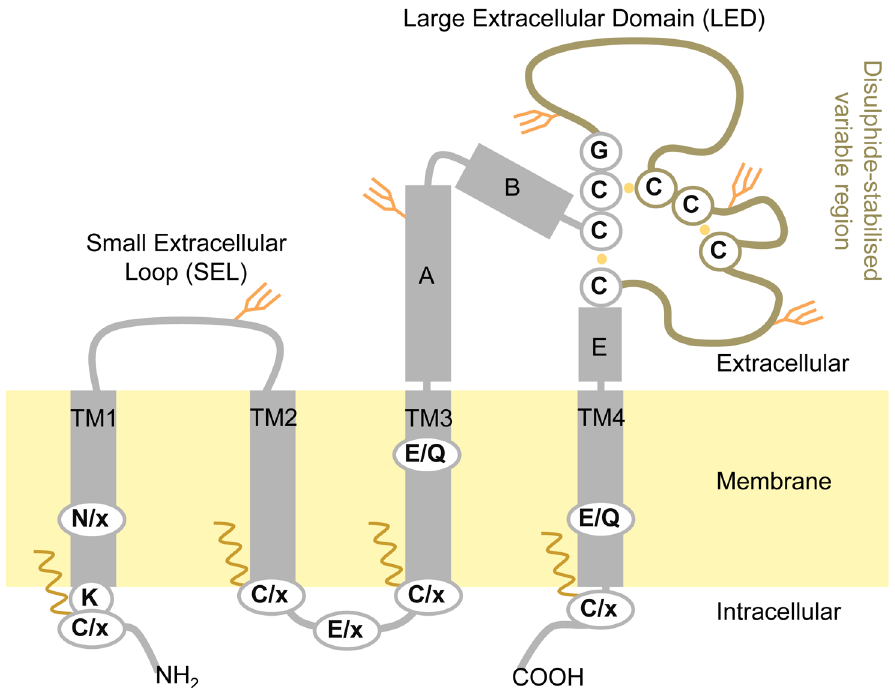
Fig 1. Tetraspanin topology scheme. Transmembrane helices are numbered 1 – 4, conserved helices in the large extracellular domain indicated with letters A,B,E according to nomenclature by Seigneuret et al. [32] . Conserved residues are shown in circles, where x stands for any amino acid. Possible post-translational modifications are indicated as palmitoylation sites shown as waves close to the intracellular side of the protein and available N-linked glycosylation sites shown as forks on the extracellular